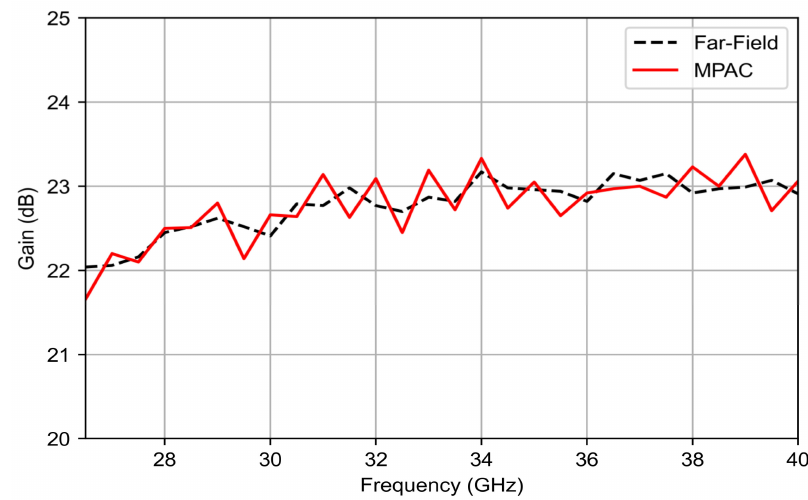
Figure 9. Swept-frequency gains.